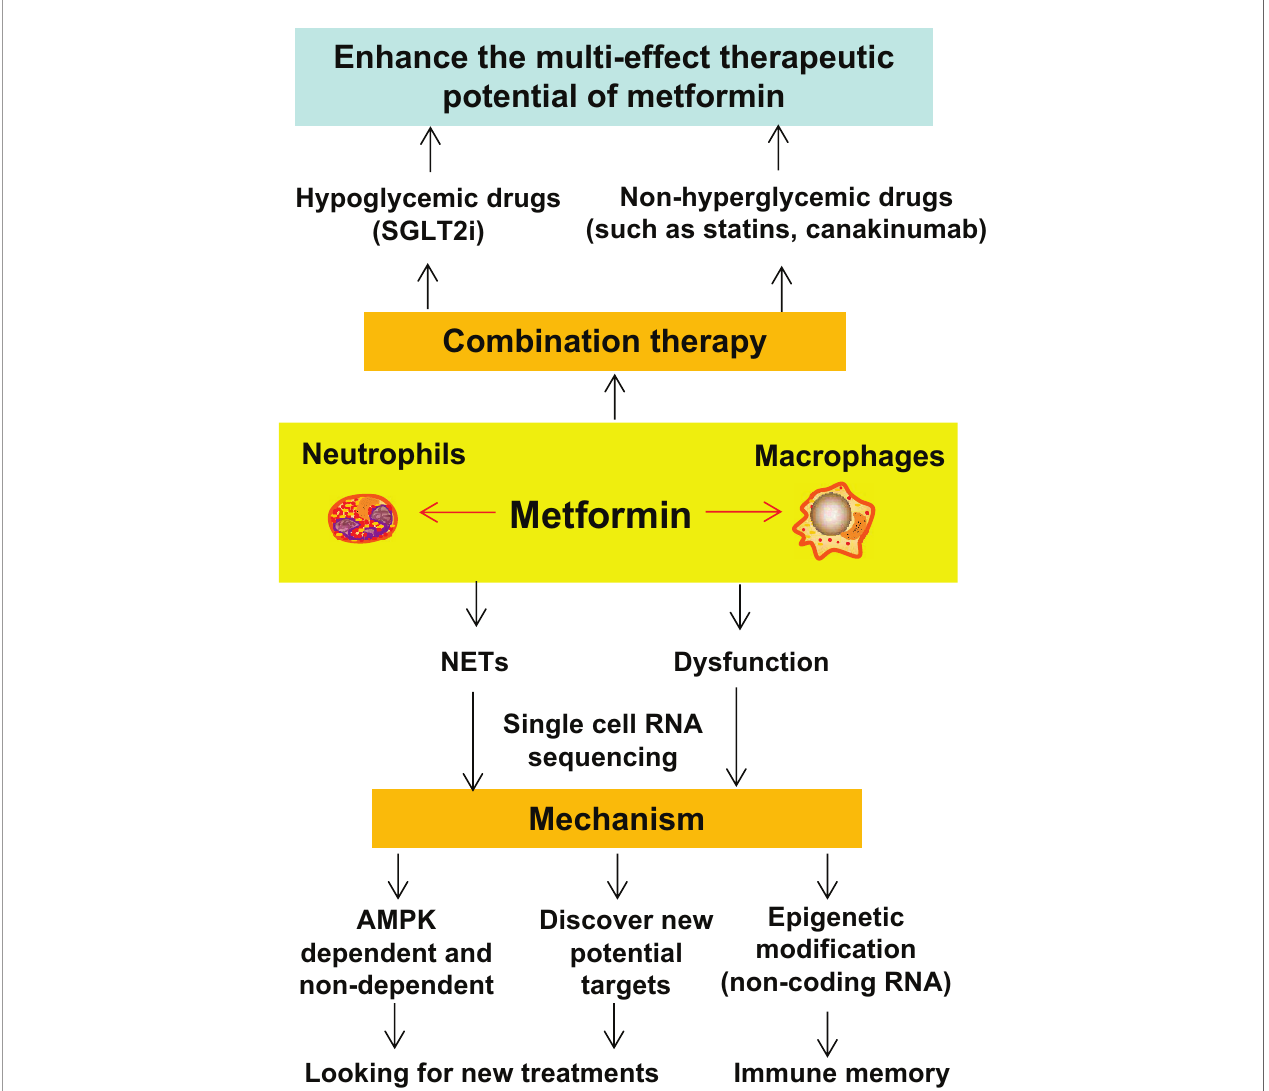
FIGURE 4 | Future directions of studying the pharmacological actions and molecular mechanisms of metformin in atherosclerosis. Numerous studies have demonstrated the protective effects of metformin on macrophage function, however, the effect of metformin on atherosclerosis in experimental animal models and humans are warranted. Recent studies have shown that neutrophils (the most abundant white blood cells in healthy people) can participate in the development of AS through the formation of NETs. Moreover, single-cell RNA sequencing plays an increasingly important role in revealing various physiological and pathological mechanisms, and can be further utilized to uncover the effects of metformin on monocytes/macrophages and neutrophils. This will provide important clues for the study of immune memory and the exploration of new treatment methods. In addition, the combination of metformin and other drugs (such as statins and SGLT2i) synergistically improves the function of macrophages, further enhancing the pleiotropic effects of metformin. NETs, neutrophil extracellular traps; SGLT2i, sodium- glucose cotransporter 2